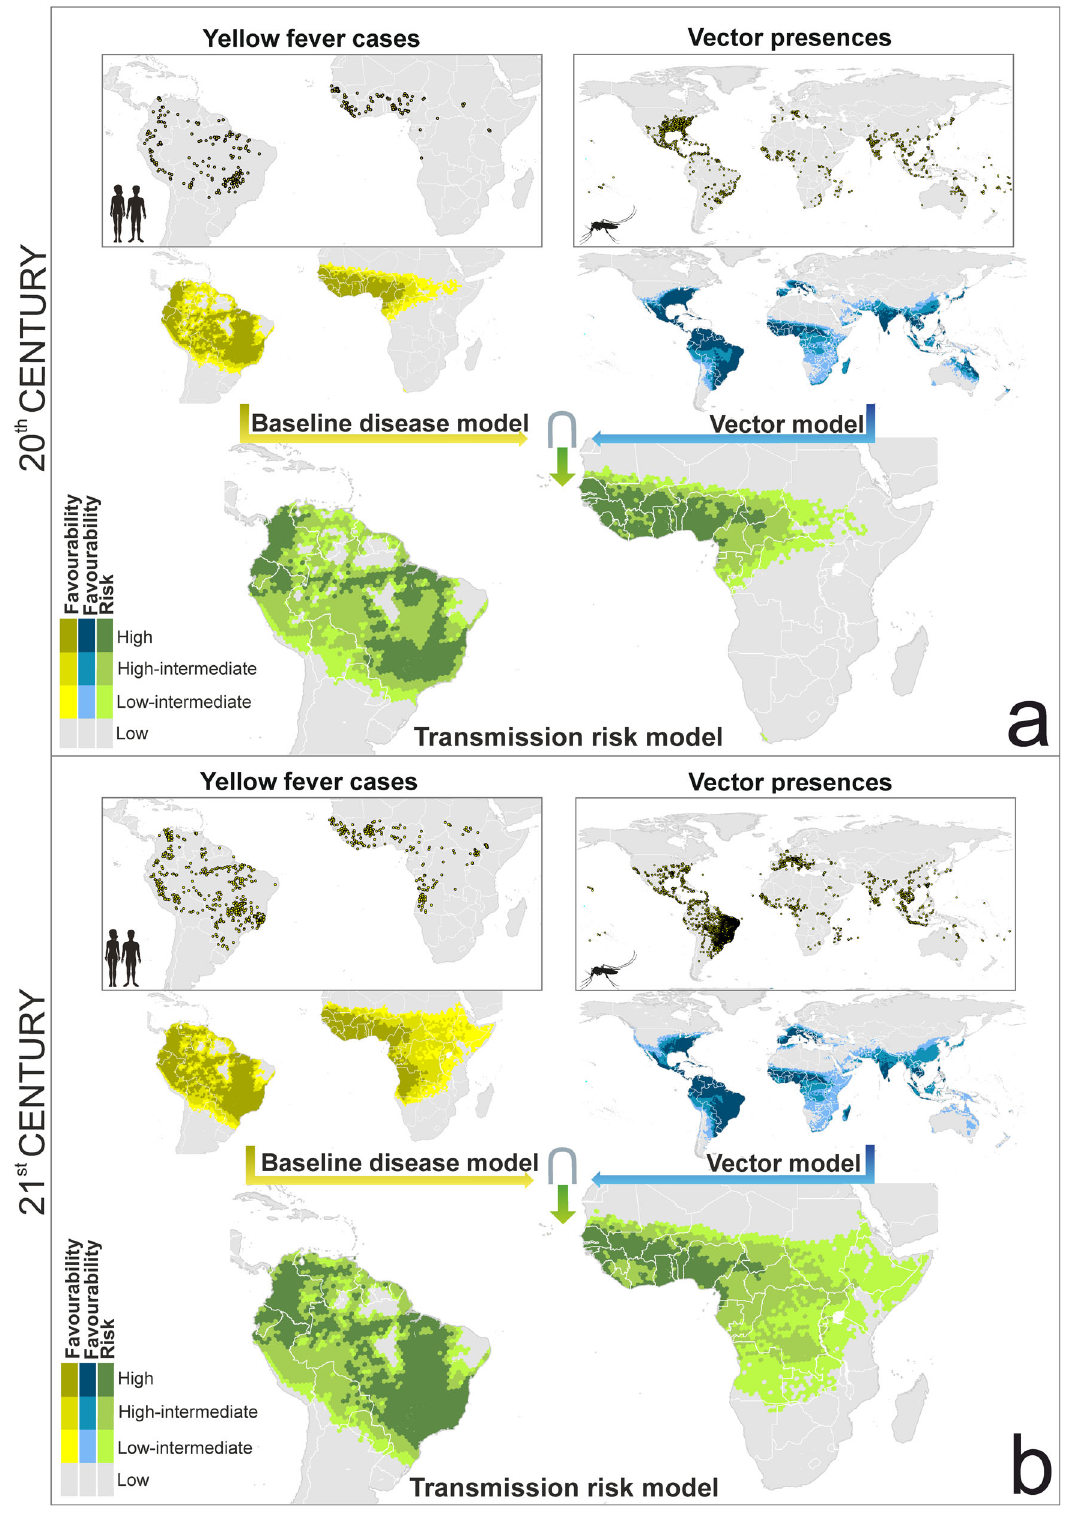
Fig. 3 Global baseline disease, vector and transmission-risk model. a maps for the late 20th century. b maps for the early 21st century. The risk of transmission is estimated as the fuzzy intersection ( ∩ ) between favourable conditions for the occurrence of yellow fever cases, and favourable conditions for the presence of vector species. The Favourability values were considered on the following scale: High (F > 0.8); High-Intermediate (0.5 ≤ F ≤ 0.8); Low- Intermediate (0.2 ≤ F < 0.5); and Low (F < 0.2). The spatial resolution is based on 7,774-km 2 hexagons. Recorded occurrences of yellow fever cases and of vector presences are also mapped (see “ Yellow fever datasets ” and “ Vector dataset ” in the Methods section for details). Mosquito and humans clip art source: http://www.freepik.com.